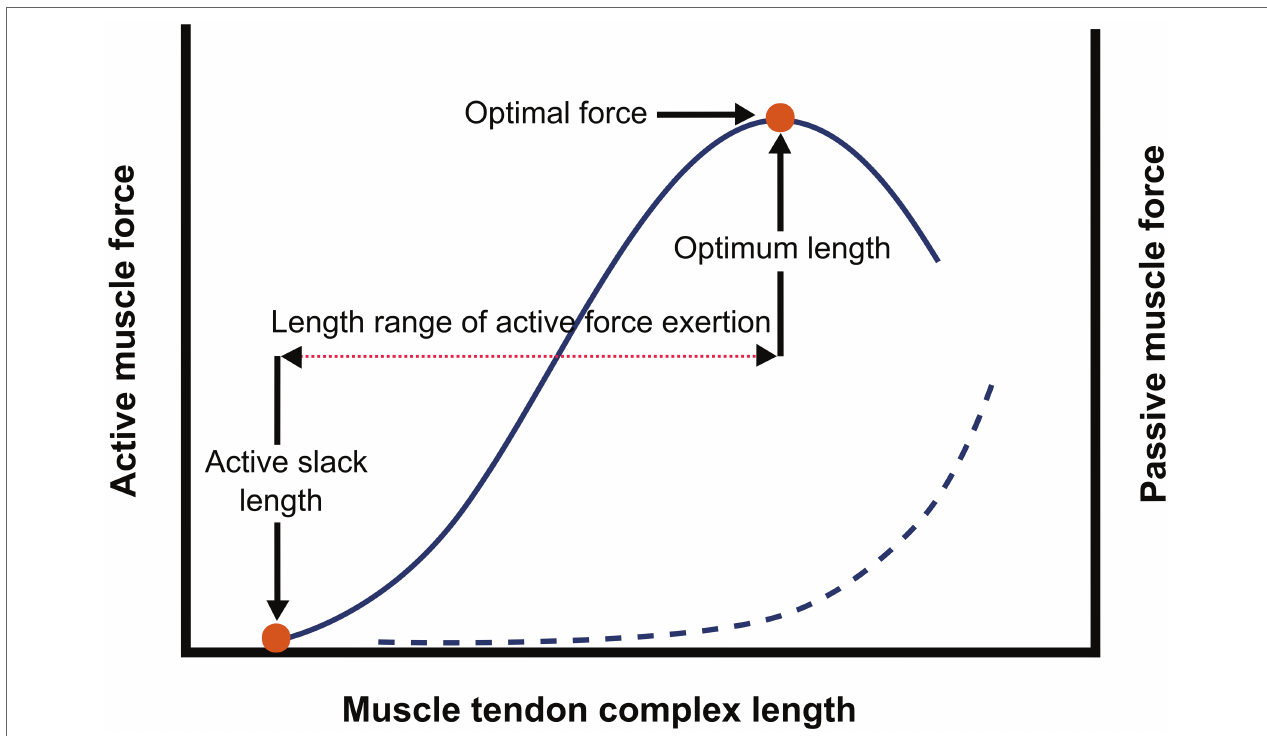
FIGURE 1 | Schematic representation of the active and passive length-force relationship of a muscle. The figure illustrates the active length-force curve (continuous line), the red dots show the active slack length (length at which the muscle does not active exert force) and the optimum muscle length length of the active muscle at optimum length), together with the optimal muscle force, these are measures of the length range of active force exertion (···). The exponential curve (---) shows the passive force, which can be explained as the exerted resistance to stretch caused by passive elastic